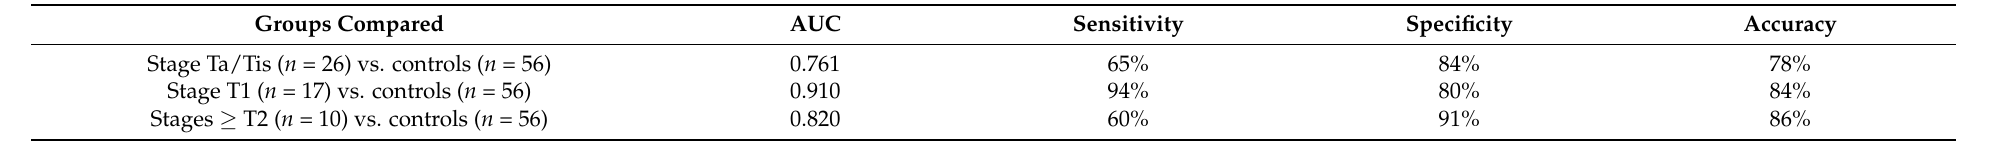
Table 3. Performance of the set of seventeen significantly different volatiles for detection of BC stages by ROC analysis.